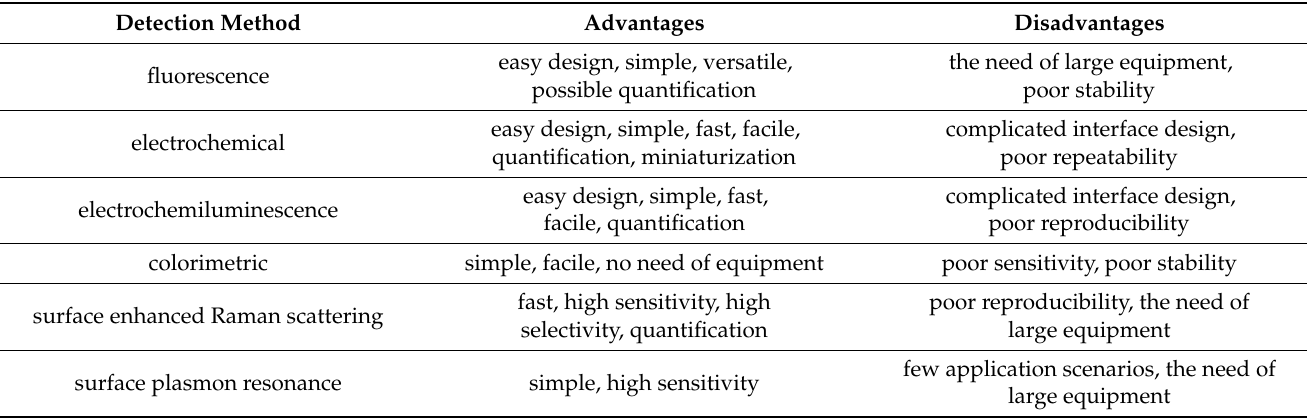
Table 2. Comparison of different detection